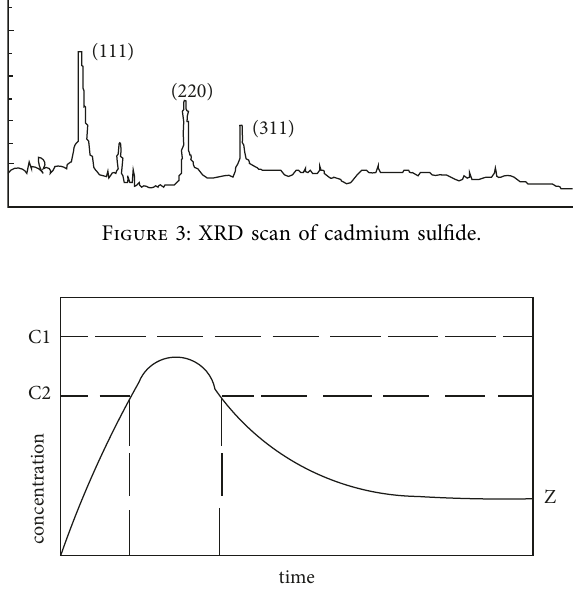
Figure 4: Lamer model of a single particle in the dispersed